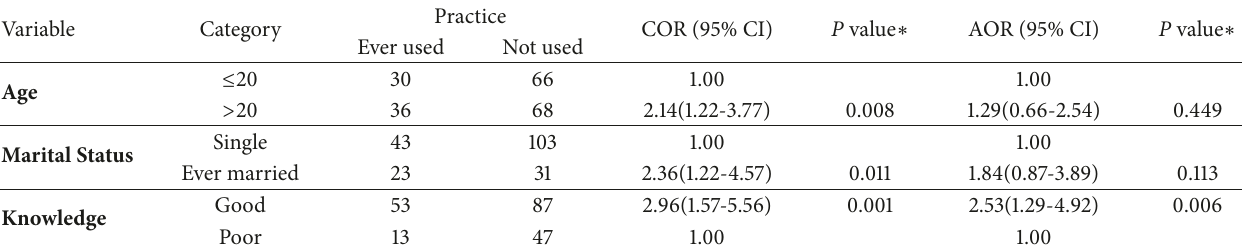
Table 5: Univariate and multivariate analysis of factors associated with practice of EC among female college graduating students, Harar, eastern Ethiopia, 2016 (N=200).